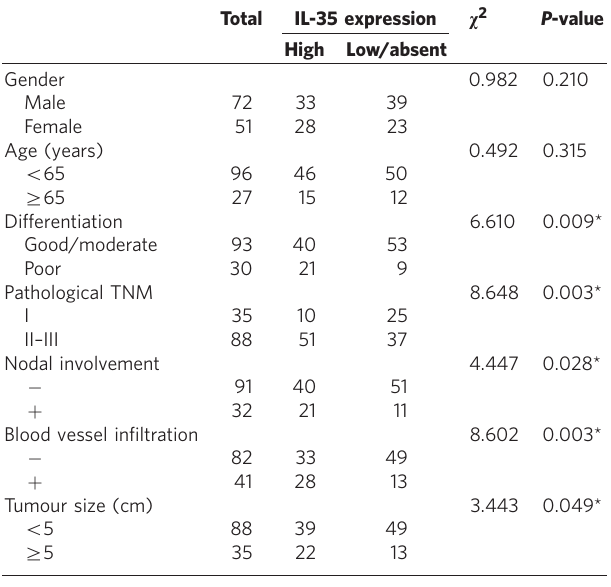
Table 1 | Association between IL-35 expression and clinicopathological features of patients with pancreatic carcinoma tissues.